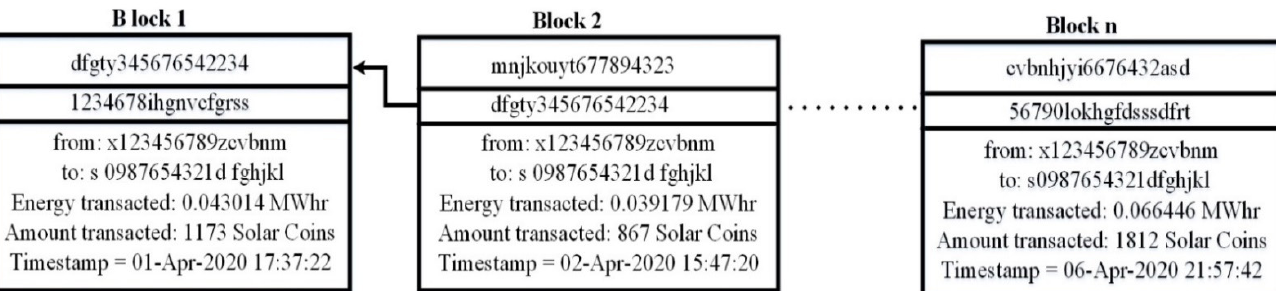
Figure 10. Blockchain transaction.